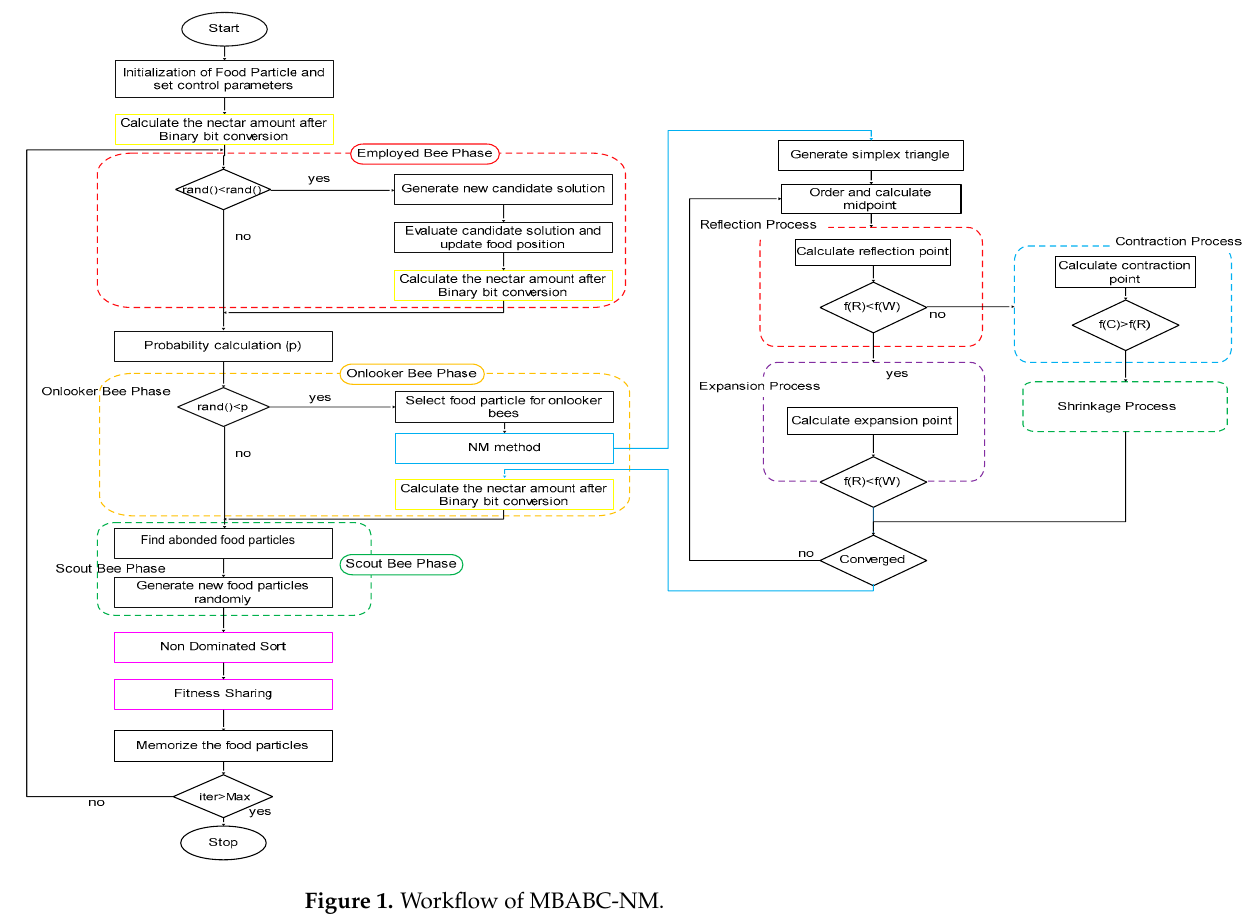
Figure 1. Work fl ow of MBABC-NM. Figure 1. Workflow of